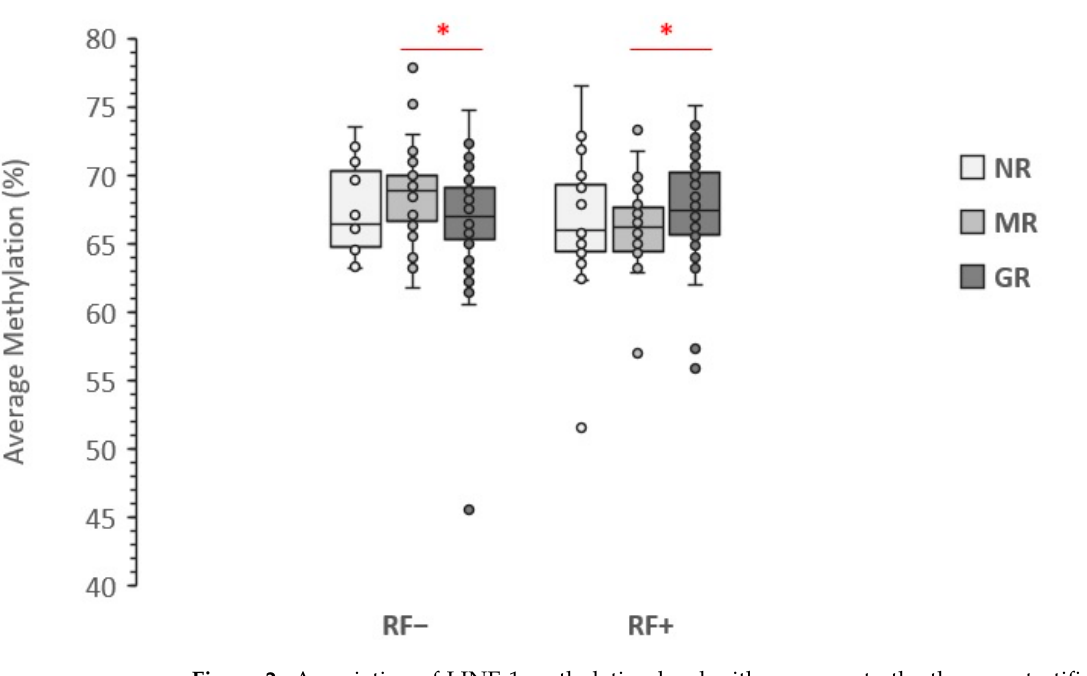
Figure 2. Association of LINE-1 methylation level with response to the therapy stratified by RF positivity. Data are presented as the average methylation percentage of five CpG sites. NR, No Response; MR, Moderate Response; GR, Good Response; * significant nominal p -value.